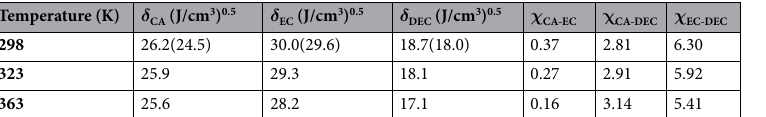
Temperature (K) δ CA (J/cm 3 ) 0.5